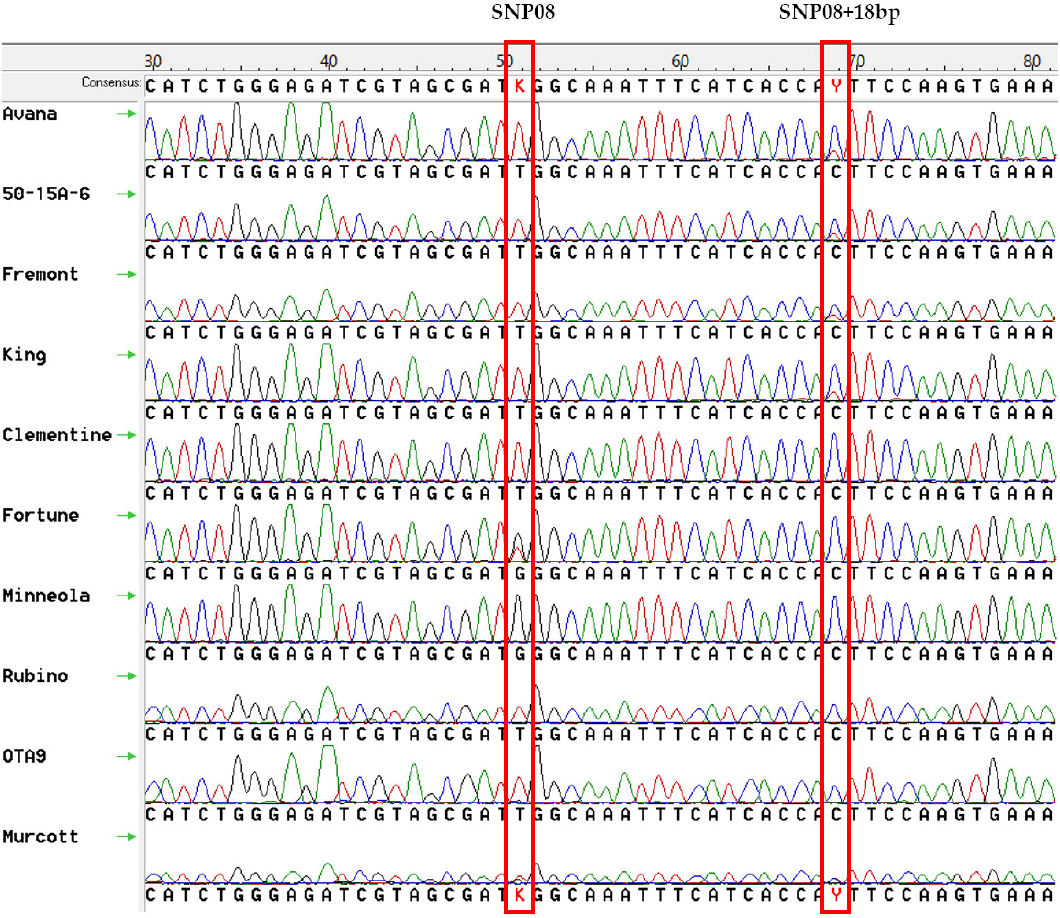
Figure 1. Alignment of the sequences flanking the SNP08 and additional SNP08+18bp in Avana, 50- 15A-6, King, Fremont, ISA (Clementine), Rubino, and OTA9 (resistant accessions) and in Fortune, Minneola and Murcott (susceptible accessions).